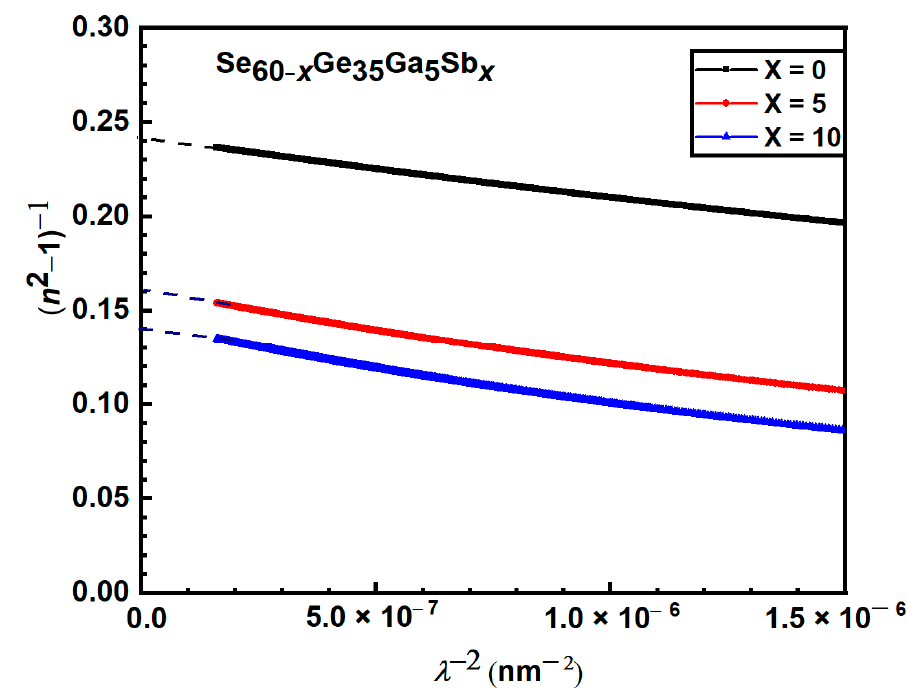
− 1 against λ − 2 for Se 60 − x Ge 35 Ga 5 Sb x thin